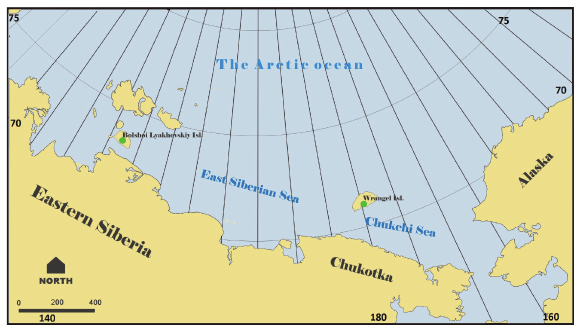
Figure 1: B. Lyakhovsky and Wrangel Islands on the map of Northern